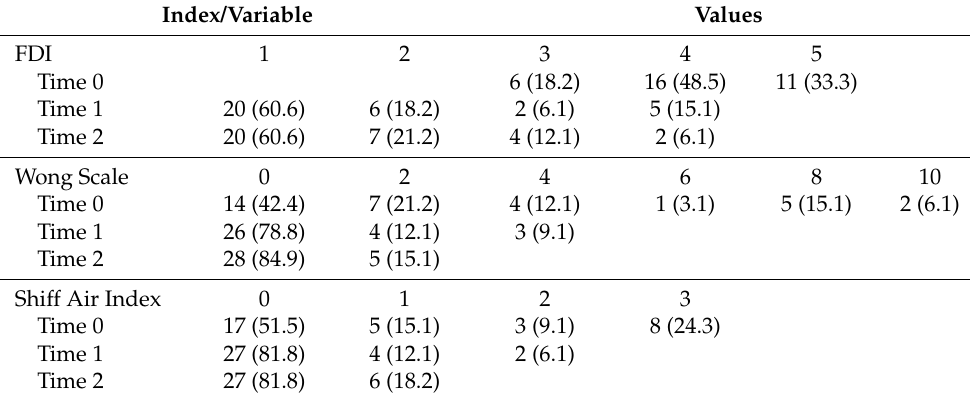
Table 2. Descriptive statistics. Absolute frequencies and percentages for total sample of repeated measurements over time of FDI, Wong–Baker Faces Pain Rating Scale, and Shiff air